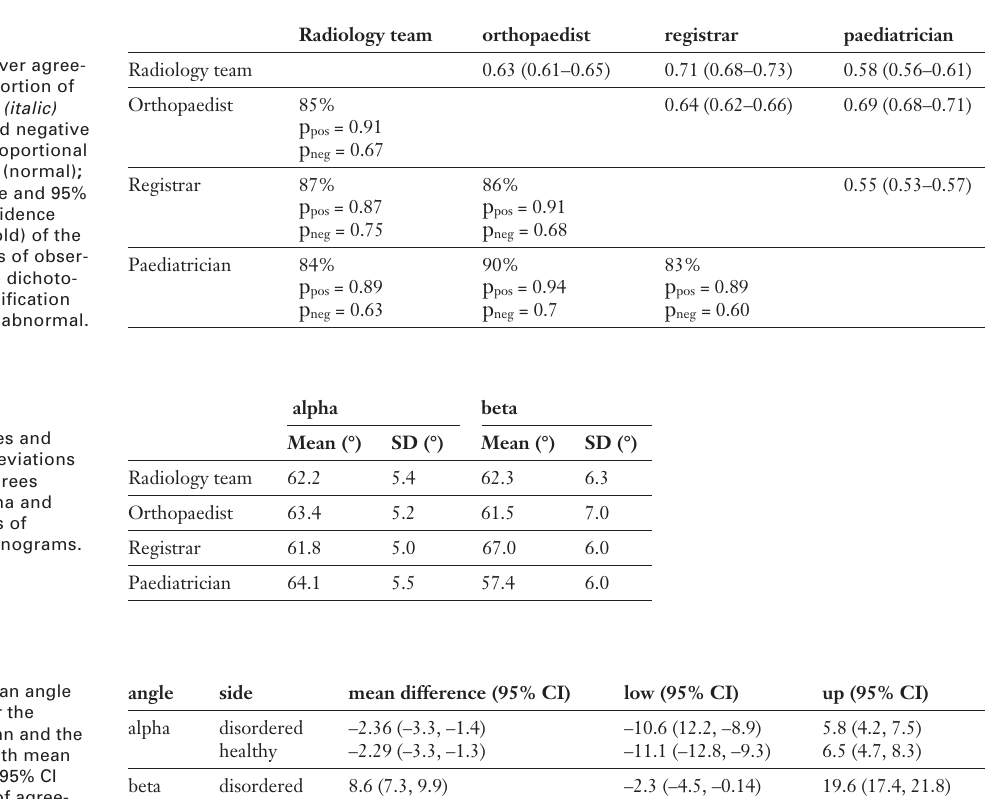
Inter-observer agree- ment between the paediatrician and the registrar in orthopae- dics with regard to normal and abnormal hips (absolute num- bers).